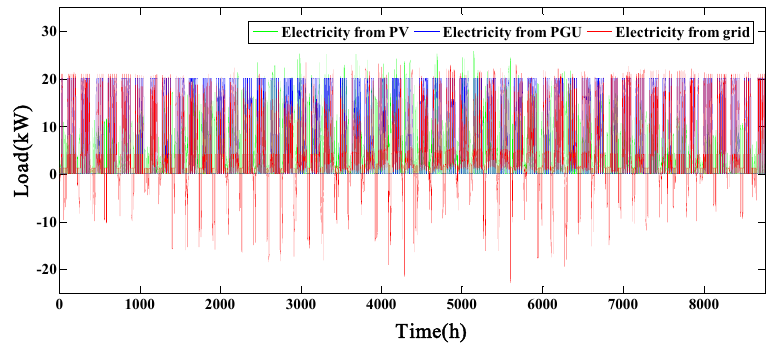
Figure 8. Annual electricity distribution of the RES–CCHP system.